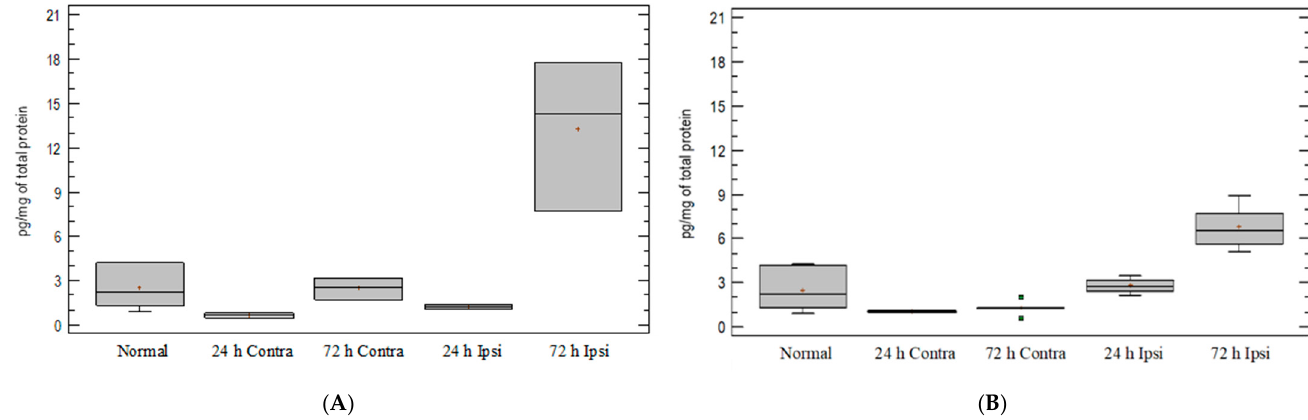
Figure 4. CCL5 expression in mouse brain after ( A ) PBS injection and ( B ) KA injection. Brains were collected 24 h and 72 h postinjection. Ipsi—ipsilateral hemisphere; Contra—contralateral hemisphere; Normal—control animals without any